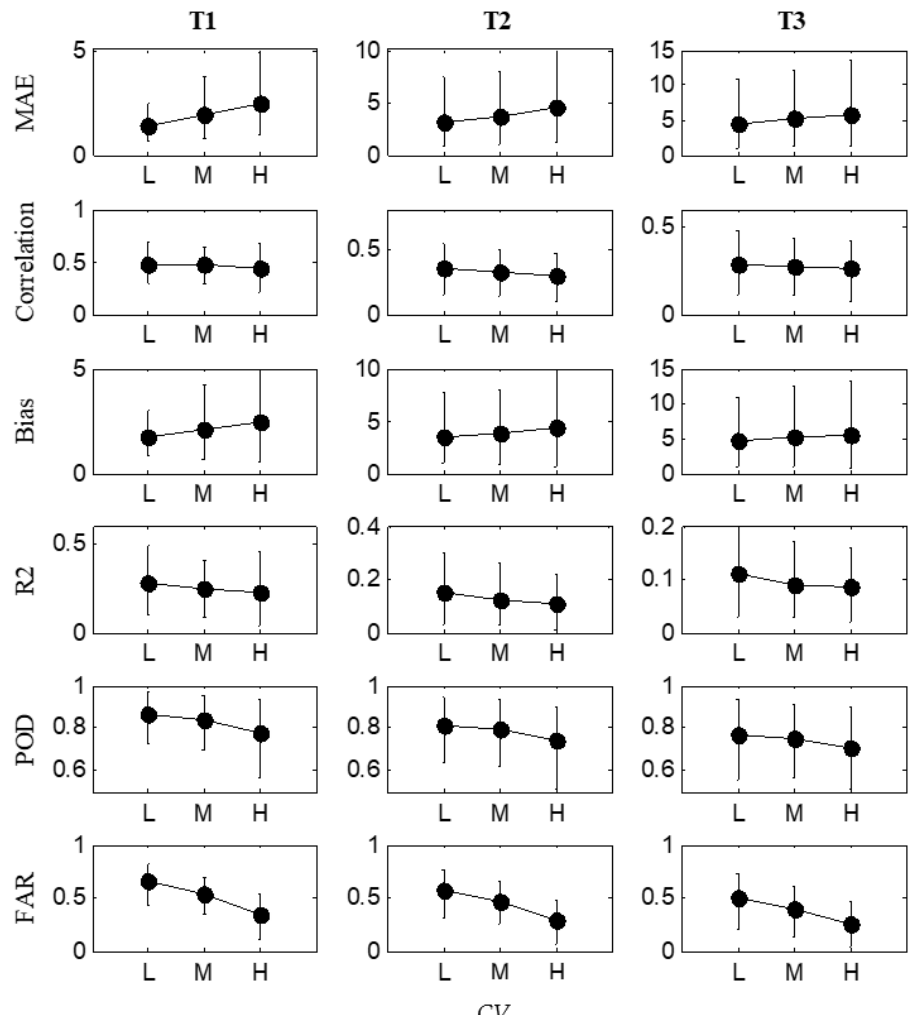
Figure 6. Relationship between the rainfall nowcasting skill and rainfall spatial coefficients of variability (CVs).